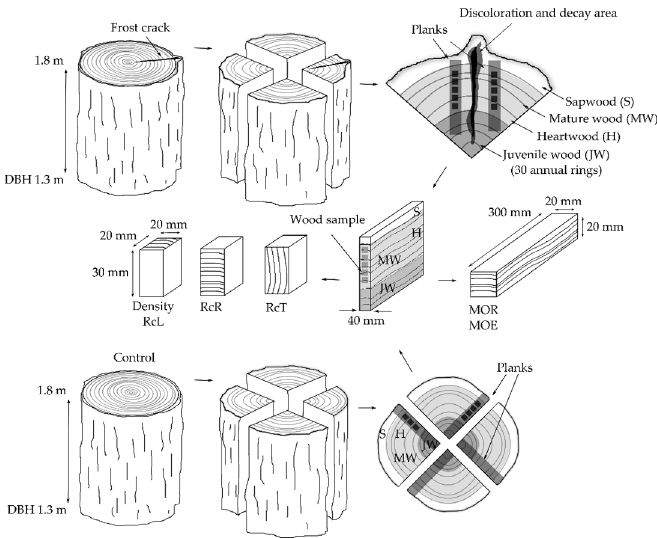
Figure 2. The method of sample preparation in oak wood with frost cracks and in control wood.